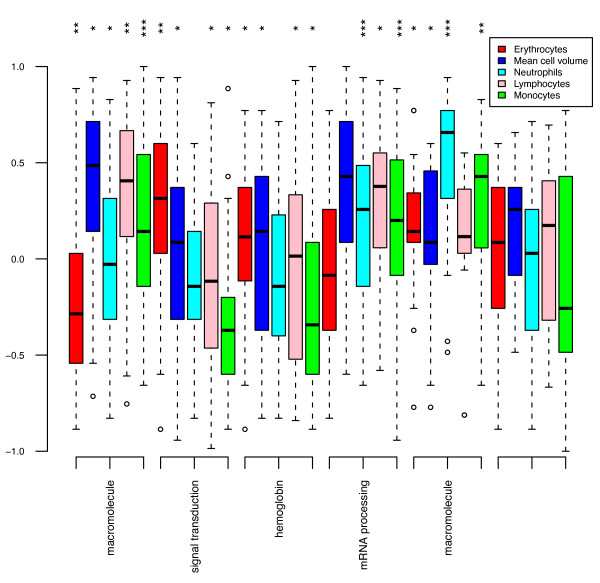
Clusters of differentially expressed probes are correlated with several parameters of blood counts (number of neutrophils, number of lymphocytes, number of erythrocytes, number of monocytes and mean cell volume). Open circles indicate outlying values in PAX. Significance levels are indicated at the top: * p-values ≤ 0.05 and > 10-5,** p-values are ≤ 10-5 and >10-10,*** p-values are ≤ 10-10.